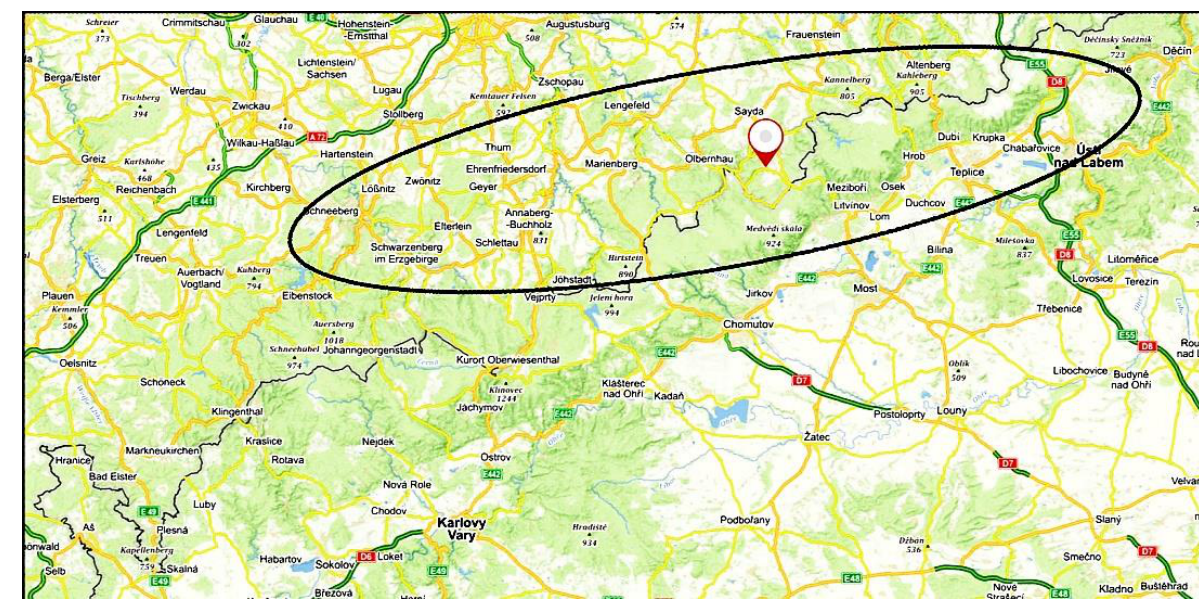
Figure 1. Map of the Northwestern quadrant of the Czech Republic and Southern Saxony. The oval indicates the approximate study area where data was collected. The town of Seiffen in Saxony is denoted by the red balloon. (Background map: mapy.cz) .